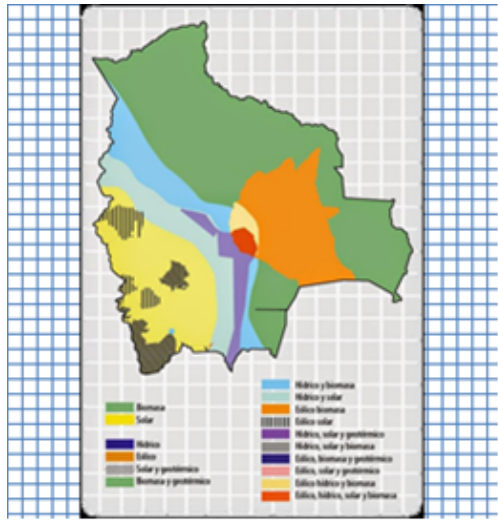
Figure 6. Renewable energypotential [53].